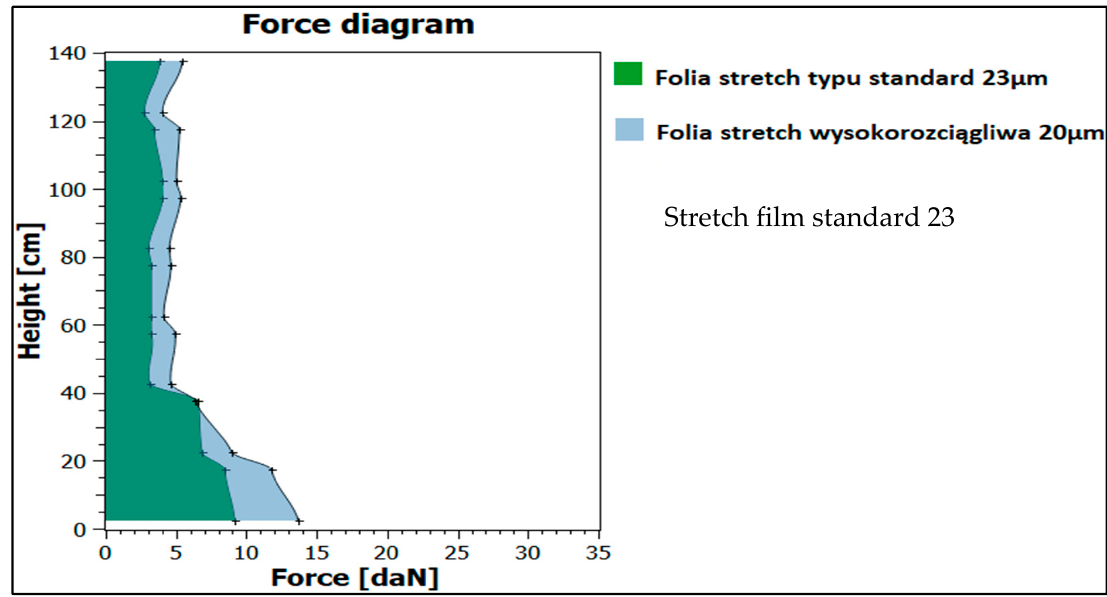
Figure 13. Characteristics of forces for the compared cargo securing films.